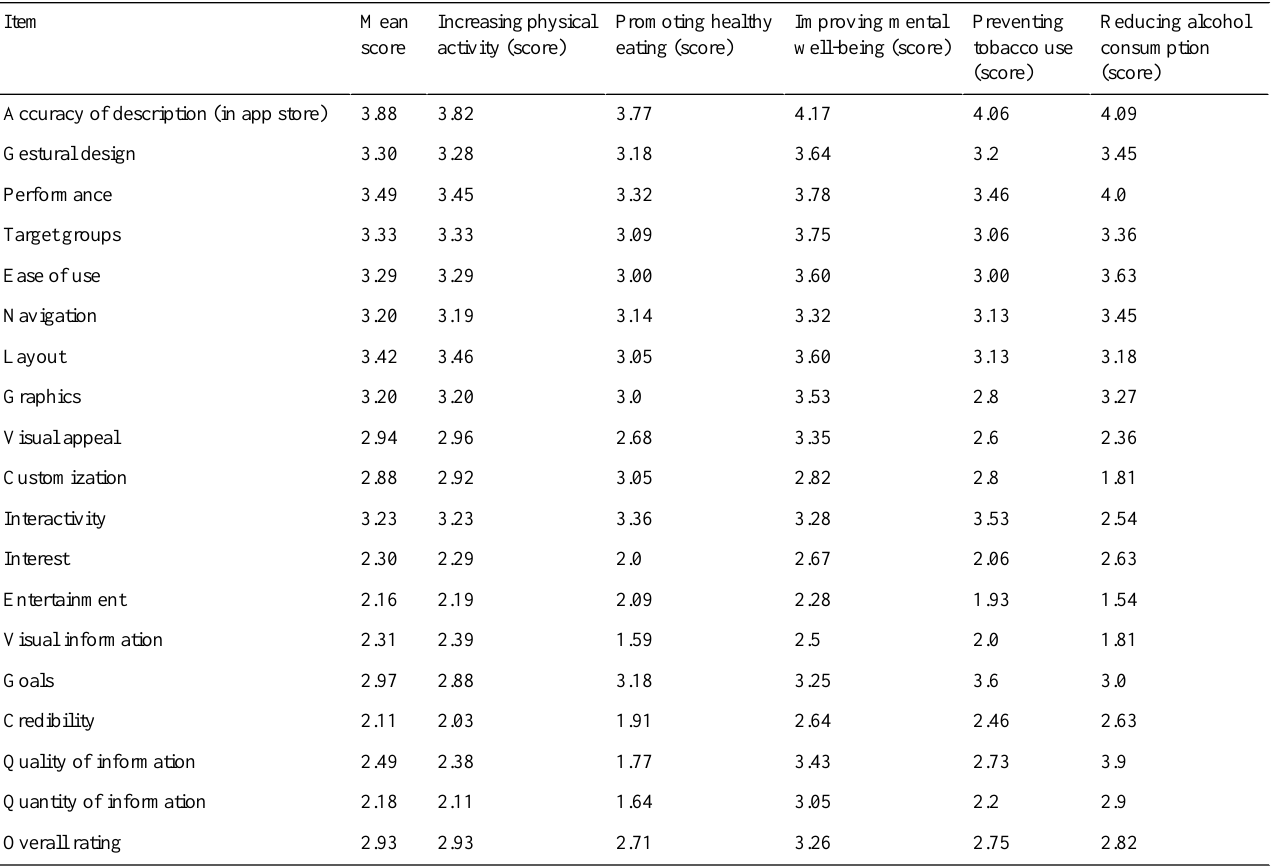
Table 2. Performance on individual Mobile App Rating Scale elements (highest to lowest).